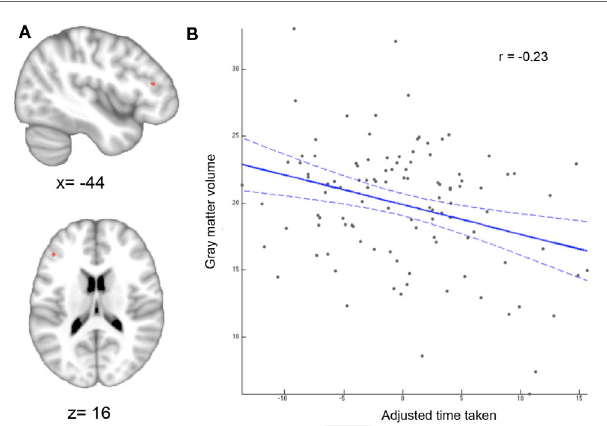
FigUre 2 | Whole-brain VBM results. (a) Region showing significant correlation between gray-matter volume and adjusted time taken. Statistical significance using non-parametric permutation inference was assessed at p < 0.05 [family-wise error (few) corrected for multiple comparisons]. (B) Correlation between motor speed and gray-matter volume. The better (lower) the performance score the higher the gray-matter volume.